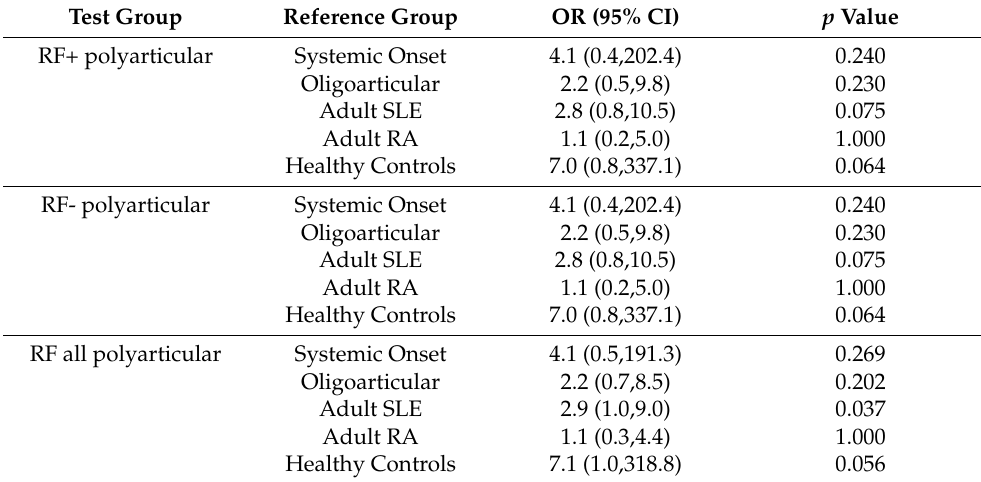
Table 4. Two-Group comparisons of 14-3-3 η test results using the 0.5 ng/mL